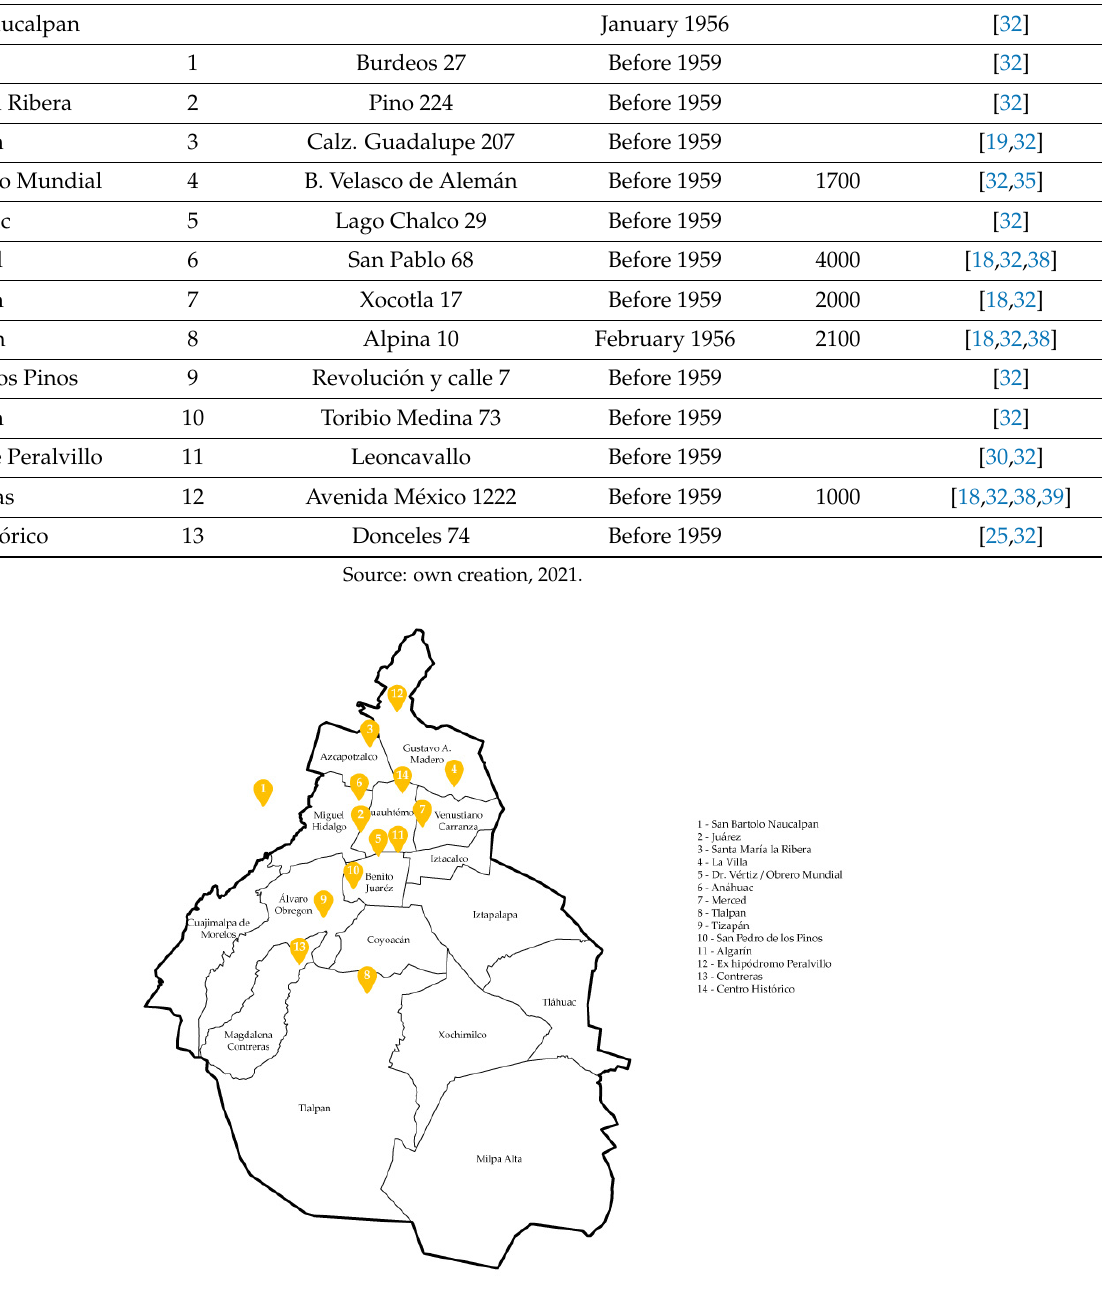
Figure 3. Location of the Casas de la Asegurada in Mexico City between 1956 and 1959